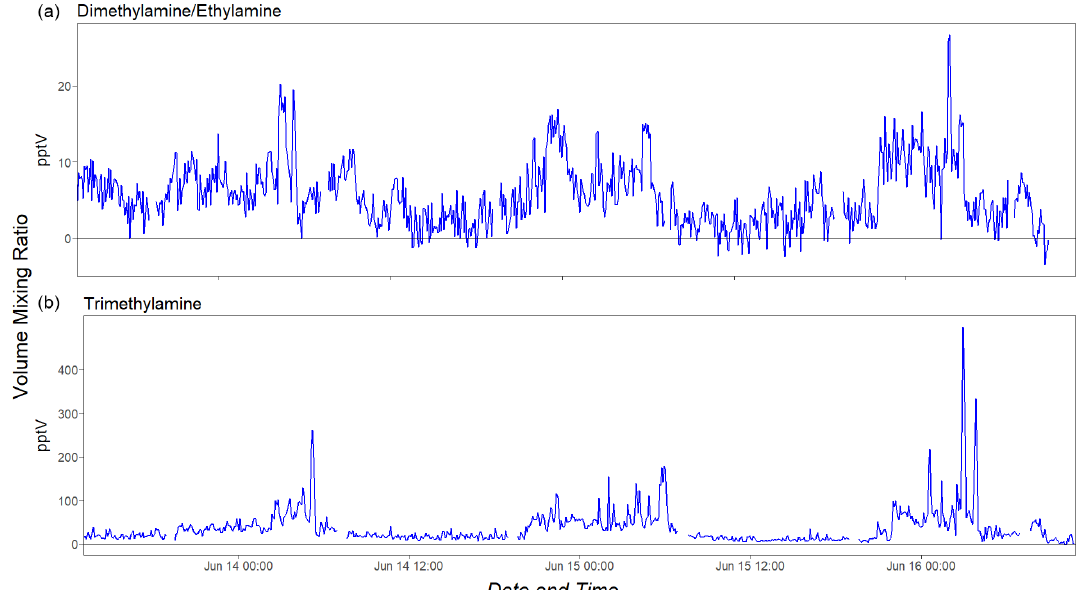
Figure 5. Time series (5min averages) of dimethylamine/ethylamine (a) and trimethylamine (b) as observed in ambient air on site of an agricultural research center.